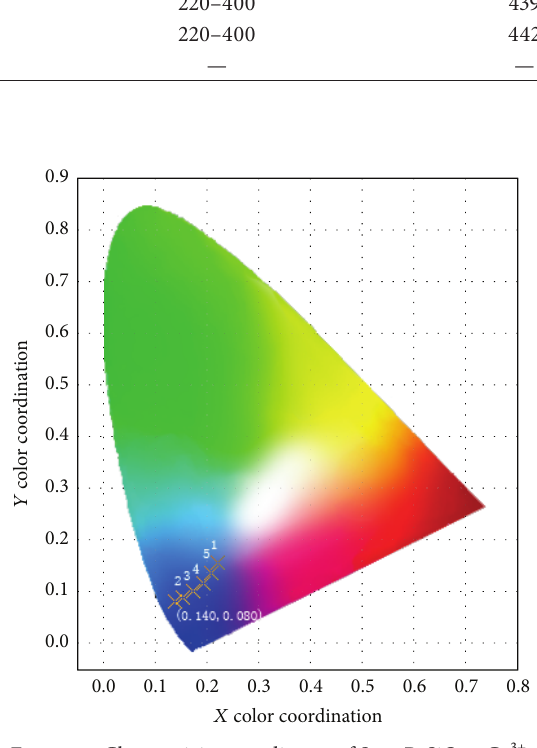
Figure 5: Chromaticity coordinates of Sr 3−𝑥 B 2 SiO 8 : 𝑥 Ce 3+